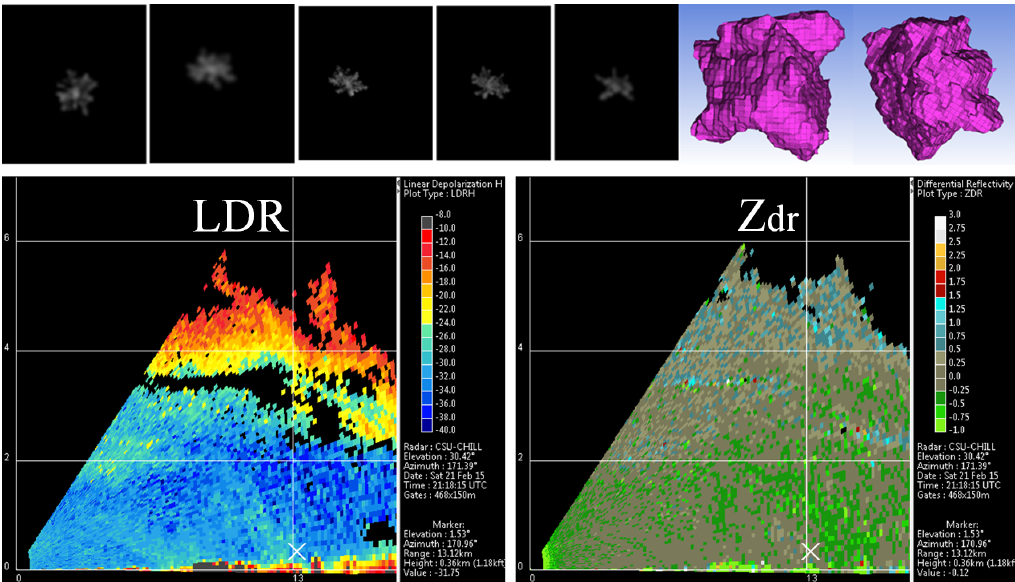
Figure 33. Some more illustrative results of MoM-SIE scattering calculations based on the MASC images captured during the 21 February 2015 event, in comparison with CSU-CHILL radar data (12.92-km range). Results: MASC/MoM-SIE: ε r = 1.201 − j0.0002, LDR = − 31.5 dB, Z dr = − 0.48 dB; CHILL Radar: LDR = − 32 dB, Z dr = − 0.12 dB.